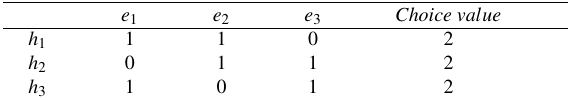
Table 9: Tabular representation of L (( F , A ) , 0 . 74 ) with choice values e 1